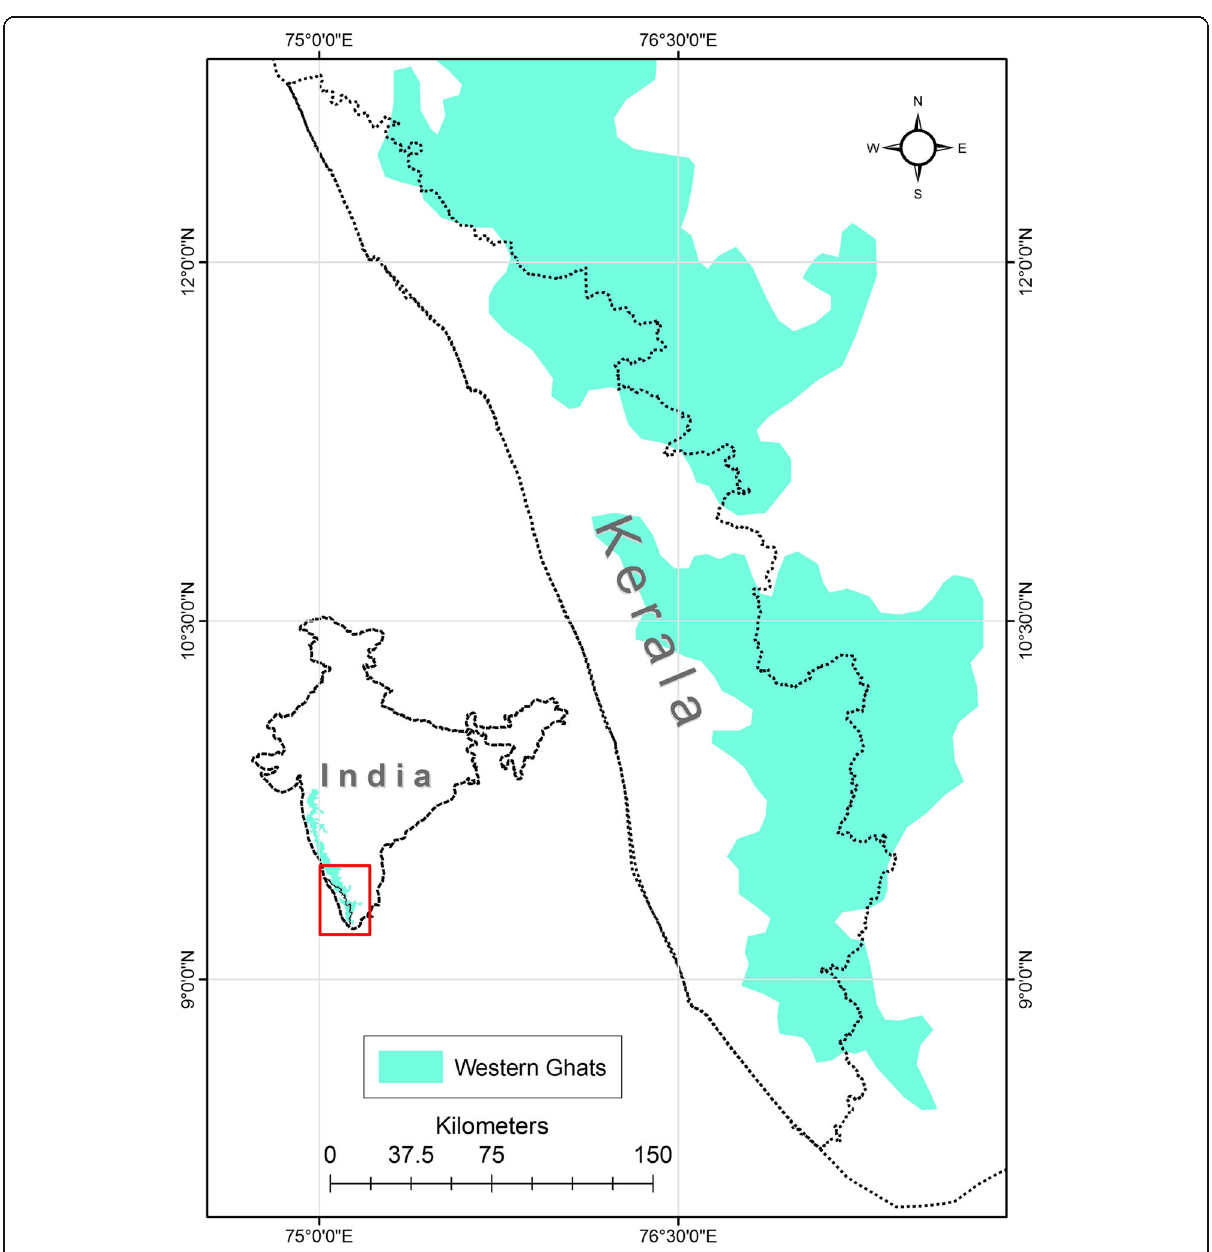
Fig. 1 Location of the Western Ghats range in